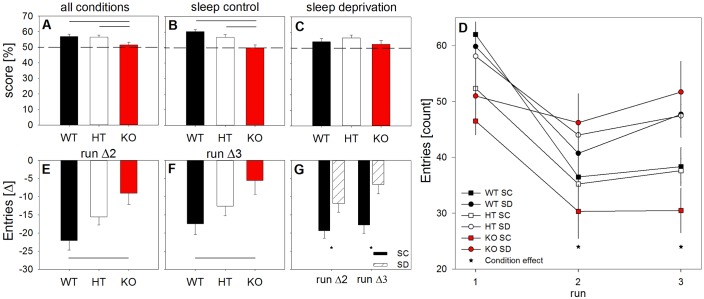
Lack of mGluR5 deteriorates working memory and habituation to a novel environment after sleep deprivation.Spontaneous alternation behavior scores in Y-maze expressed as a percentage of successful alternation trials (A-C), absolute number of total arm entries (D), and differences from the number of entries in the first maze encounter as a measure of habituation to the novel environment (E-G). Across all runs and conditions, KO mice (red bars) showed compromised working memory when compared to their littermates (‘genotype’: F2,26 = 4.29, p < 0.03). While the WT and HT mice performed above the 50% chance level in all conditions, the KO animals did not (A-C). Horizontal black lines indicate significant differences between genotypes (p < 0.03; Holm-corrected t-tests). In run 1, KO animals showed fewer total arm entries than their WT littermates. When studied after sleep deprivation (circles), mice displayed higher overall exploration than mice under control conditions (squares) (‘condition’: F1,26 > 12.1, p < 0.002). This effect of sleep deprivation on arm entries was modulated by genotype and test run (‘run’, ‘genotype’ x ‘run’, and ‘run’ x ‘condition’: Fall > 3.0, pall < 0.03). In runs 2 and 3, sleep-deprived mice lacking mGluR5 produced significantly more arm entries than control mice without mGluR5 (stars: tall < −2.3, pall < 0.05; Welch two-sample t-tests) (D). Normalization of the number of arm entries in runs 2 and 3 to run 1, confirmed the effects of sleep deprivation (‘condition’: F1,40 > 5.0, pall < 0.04) and genotype (F2,40 > 4.0, pall < 0.03) on habituation across the three test trials. More specifically, sleep deprivation attenuated habituation to the Y-maze compared to the sleep control condition, as reflected in the reduced decrease in arm entries in runs 2 and 3 relative to run 1 (stars: pall < 0.03; two-samples t-tests) (G). Finally, the sleep-deprived KO animals showed a less pronounced reduction in exploratory activity than the sleep-deprived WT animals. Horizontal black lines indicate significant differences between WT and KO mice (pall < 0.05) (E-F). All data points represent means ± SEM (n = 6–10 mice per condition and genotype).10.7554/eLife.28751.021Figure 8—source data 1.Excel file with one data sheet containing the numerical values of each figure panel (A-G) of Figure 8.